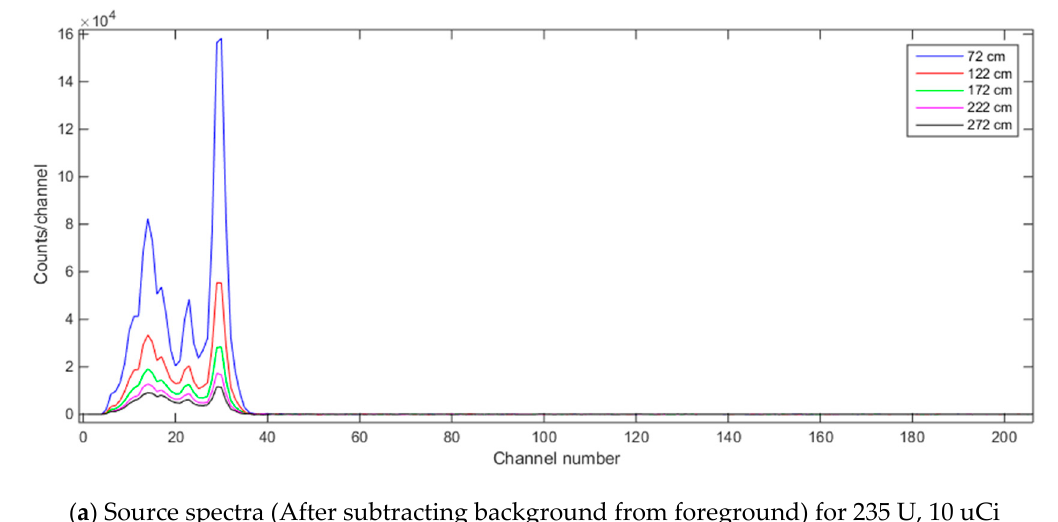
Figure 15. Source ‐ detector distance values in the test dataset.